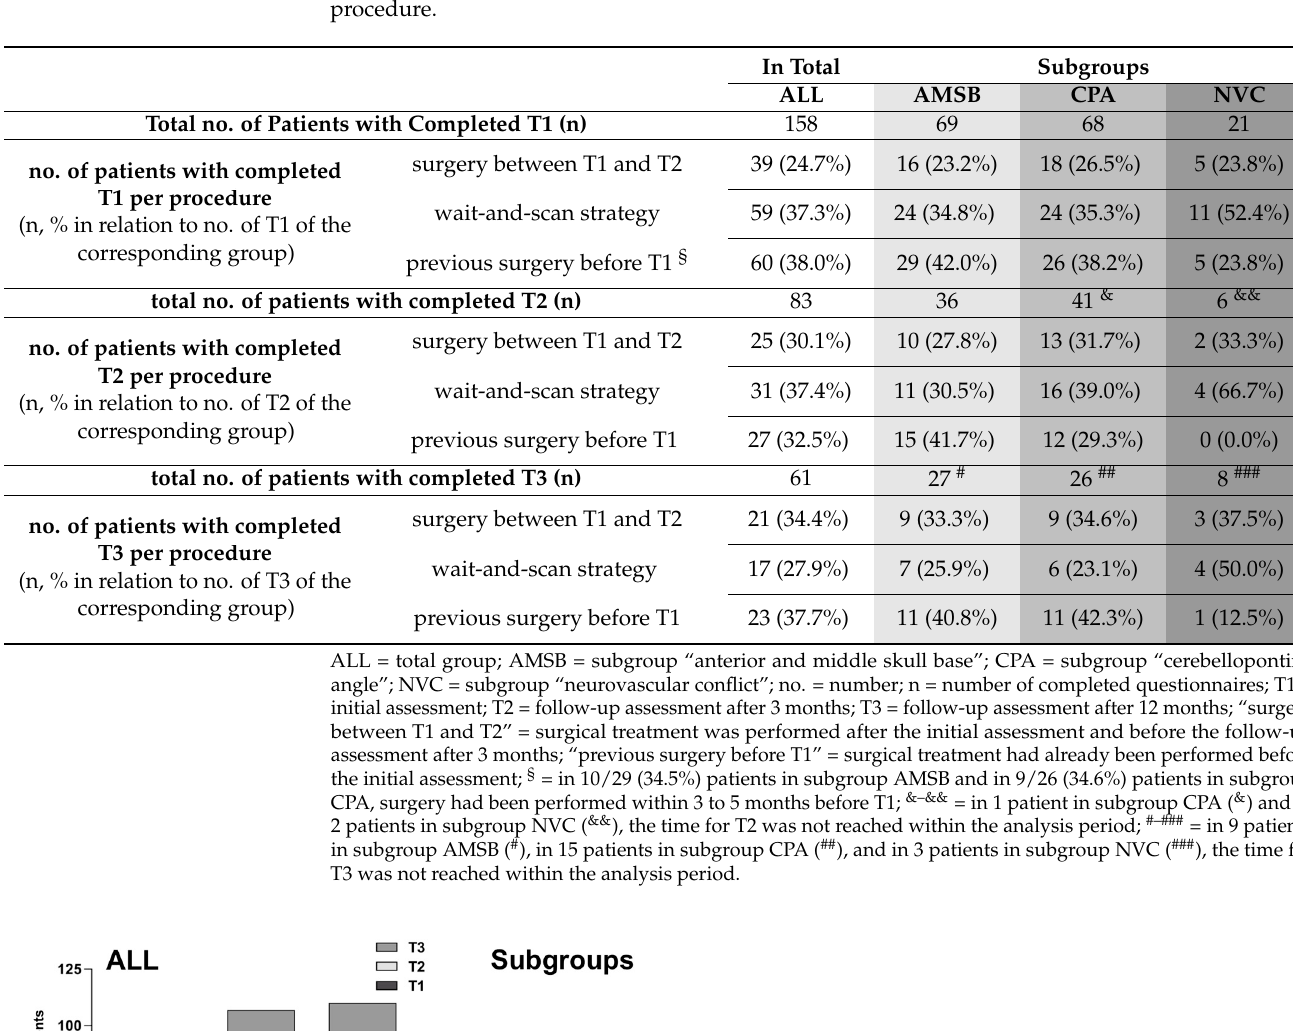
Table 1. Evaluation of the response rate to PROMs depending on subgroup and neurosurgical procedure.